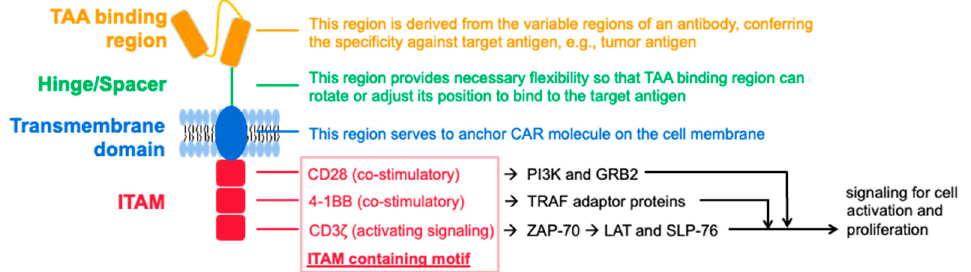
Figure 3. Cartoon illustration of the principle of the construction of CAR molecule for NK cells. The functions of different regions are indicated on the right. Intracellular events are briefly summarized and shown in